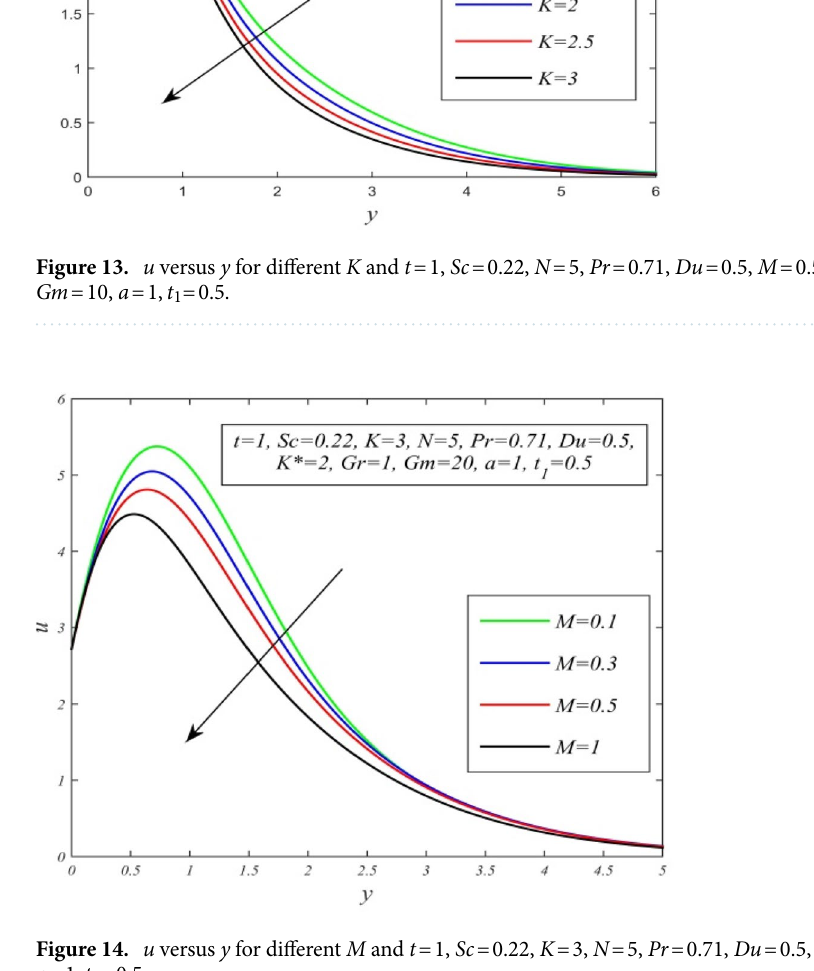
Figure 14. u versus y for different M and t = 1, Sc = 0.22, K = 3, N = 5, Pr = 0.71, Du = 0.5, K* = 2, Gr = 1, Gm = 20, a = 1, t 1 =